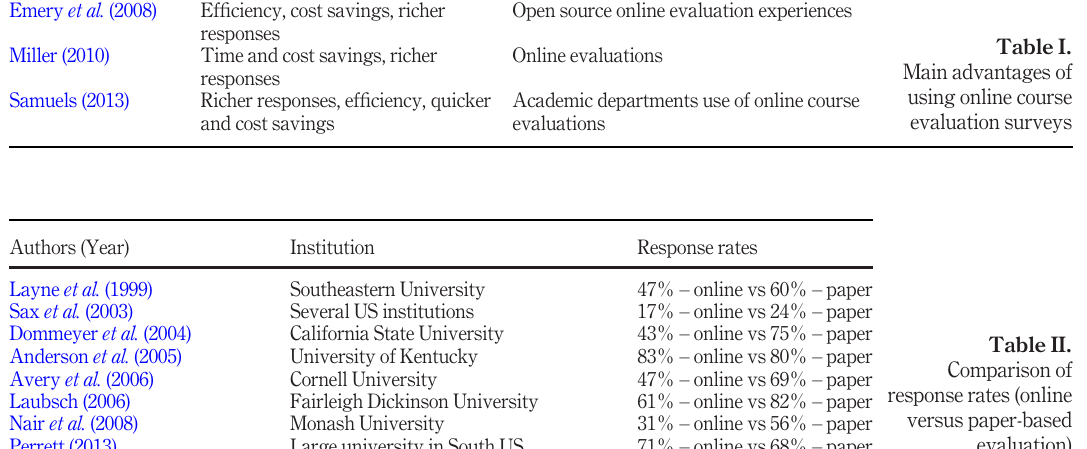
Table I. Main advantages of